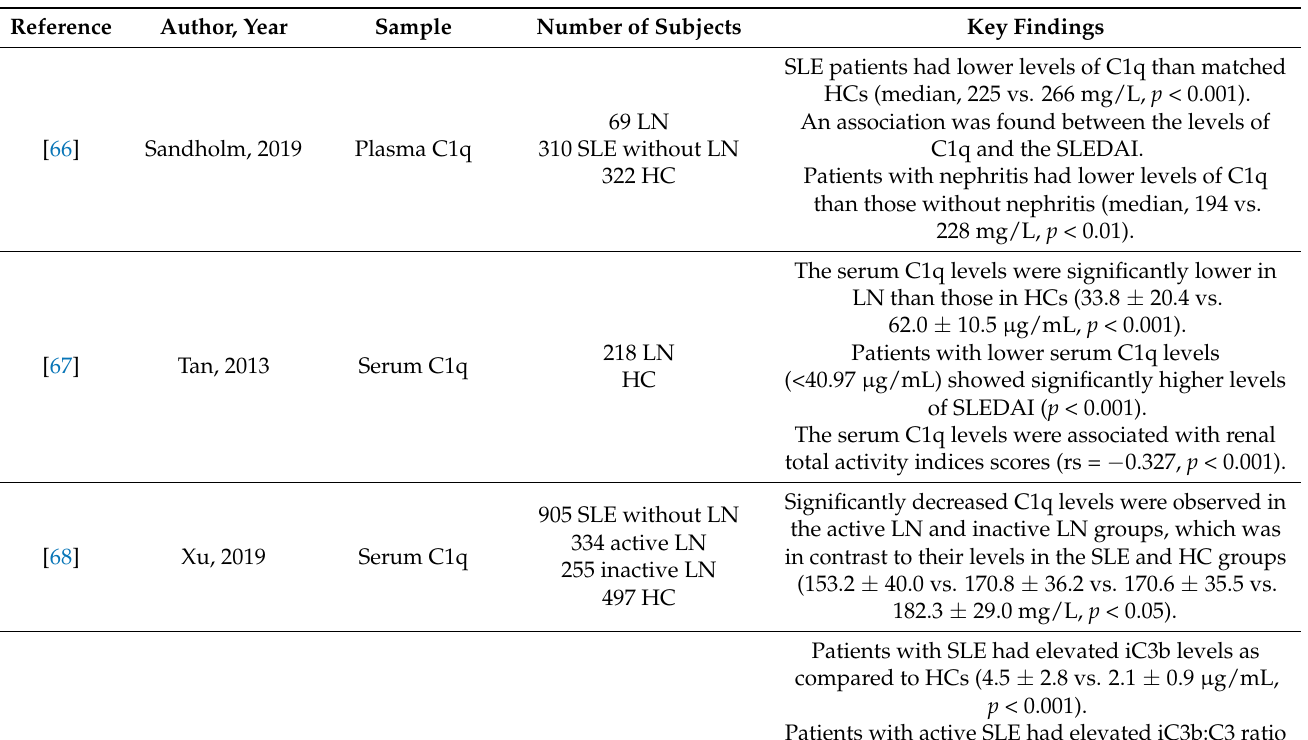
Table 2. Summary of reports on novel complement biomarkers.